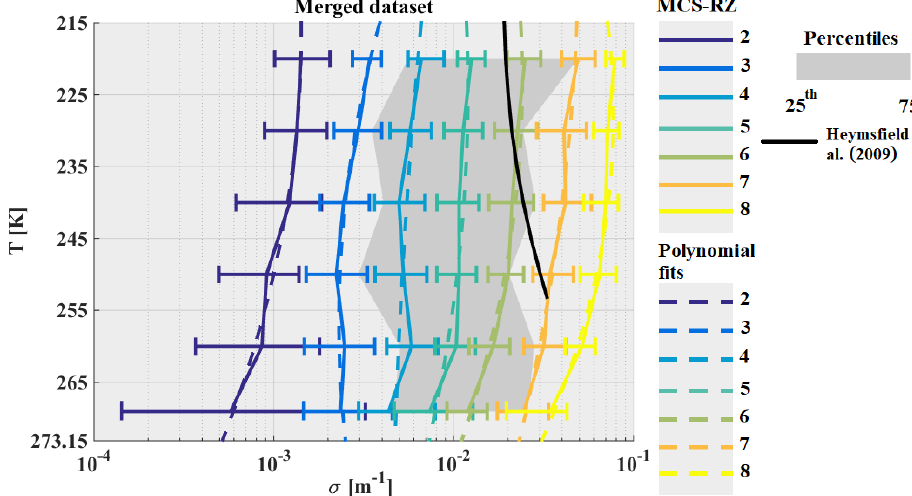
Figure 7. The same as Fig. 5 but for visible extinction σ given on x axis in m − 1 .